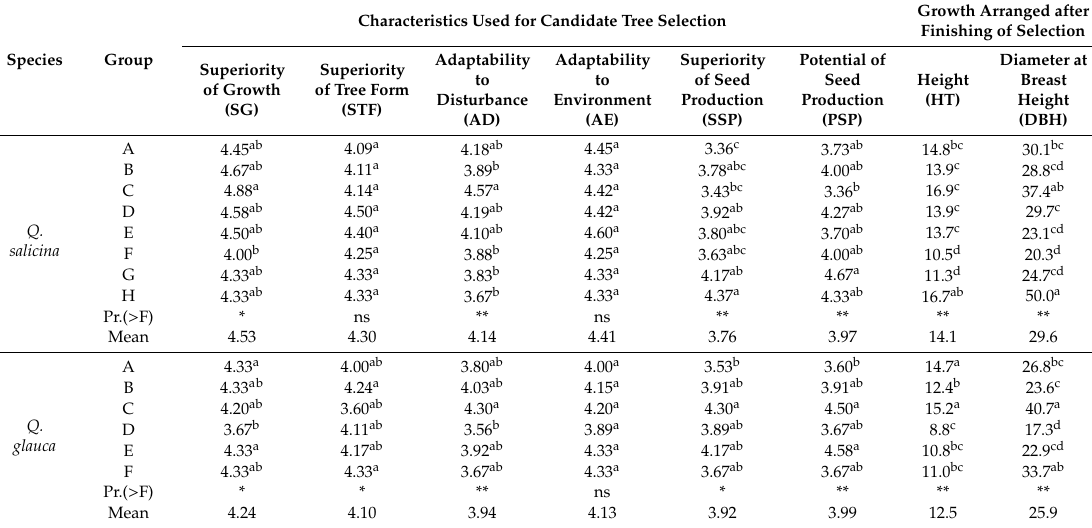
Table 4. Multiple comparisons of group mean among candidate trees in Quercus salicina and Q. glauca by Fisher’s least significant di ff erence (LSD) with Bonferrroni